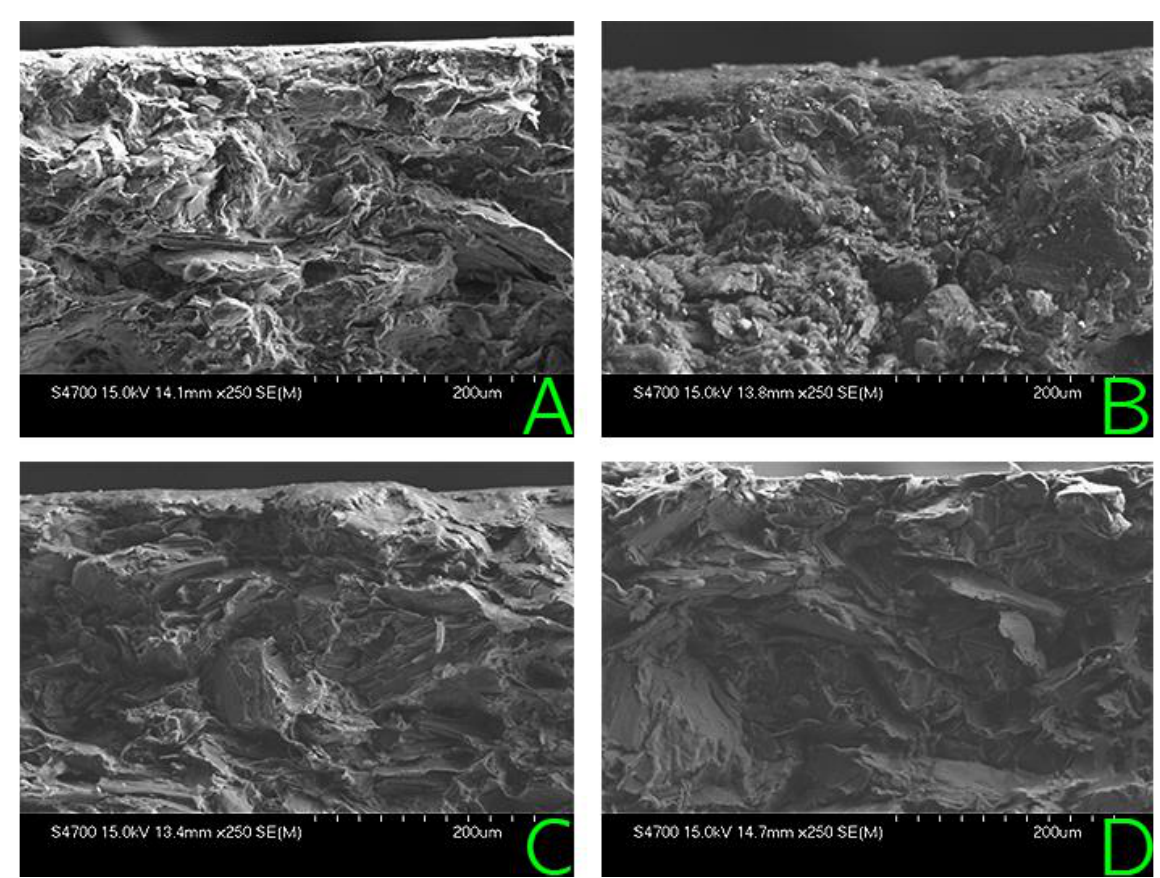
Figure 14. SEM images of the fracture plane of Eisenhuth PPS before chemical degradation ( A ), after chemical degradation ( B ), Shin Etsu BPB-PP before chemical degradation ( C ) and after chemical degradation ( D ).